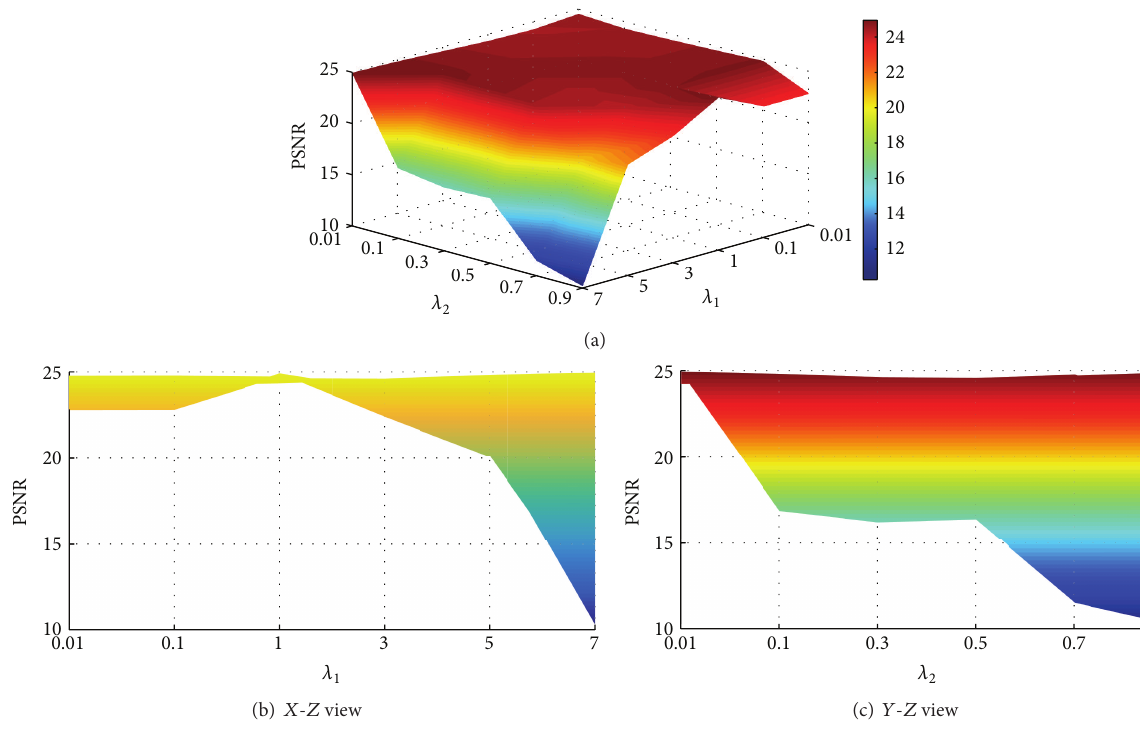
Figure 12: Relationship between the parameters 𝜆 1 and 𝜆 2 and PSNR.